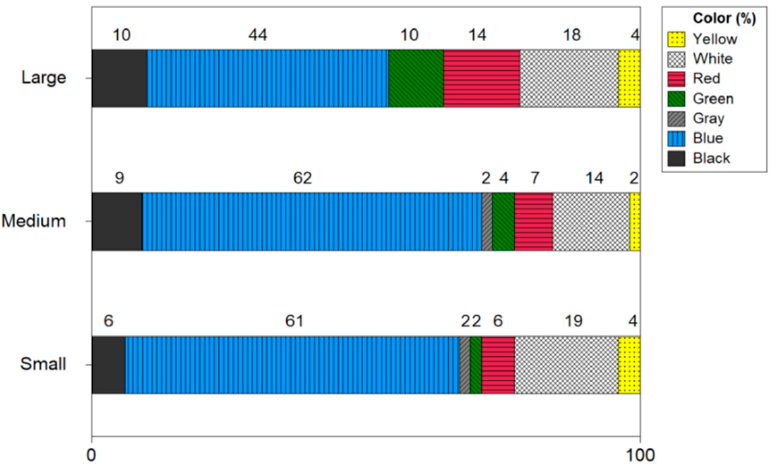
Figure 8. Color of microplastics by size of shrimp.